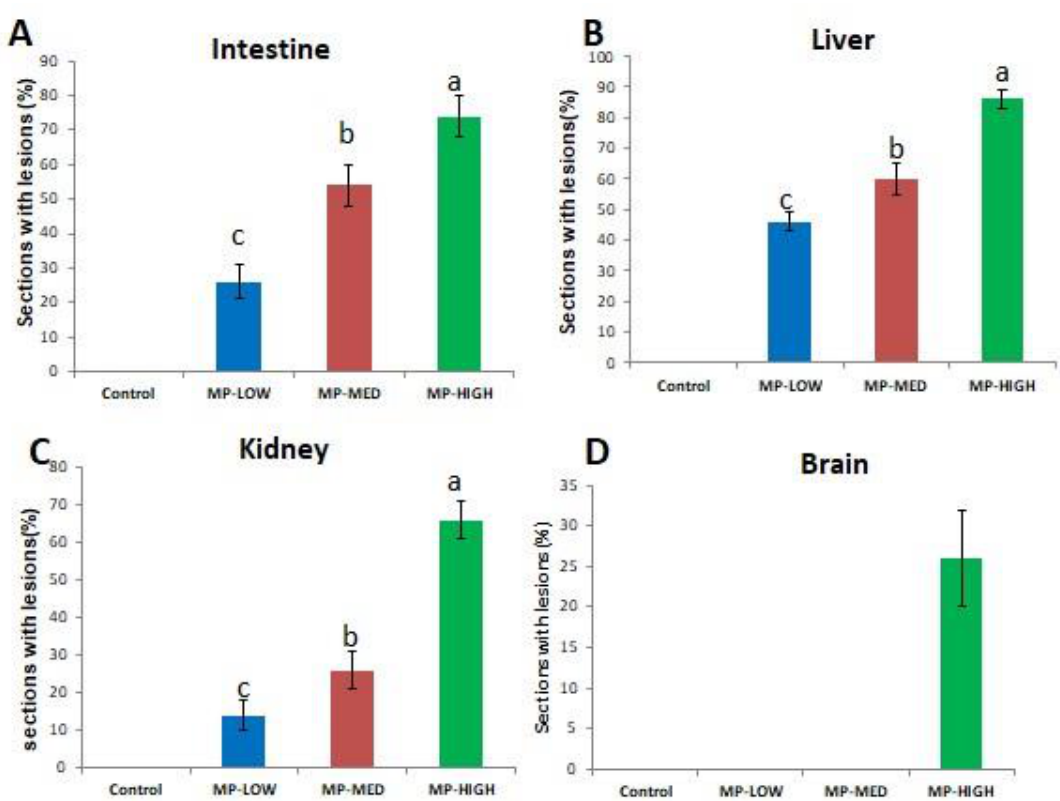
Figure 5. Representative photomicrograph of brain tissue: ( A ) Control group with normal tissue, ( B ) MP-LOW, no lesion, ( C ) MP-MED, no lesion and ( D ) MP-HIGH group showing cerebral oedema (CO).